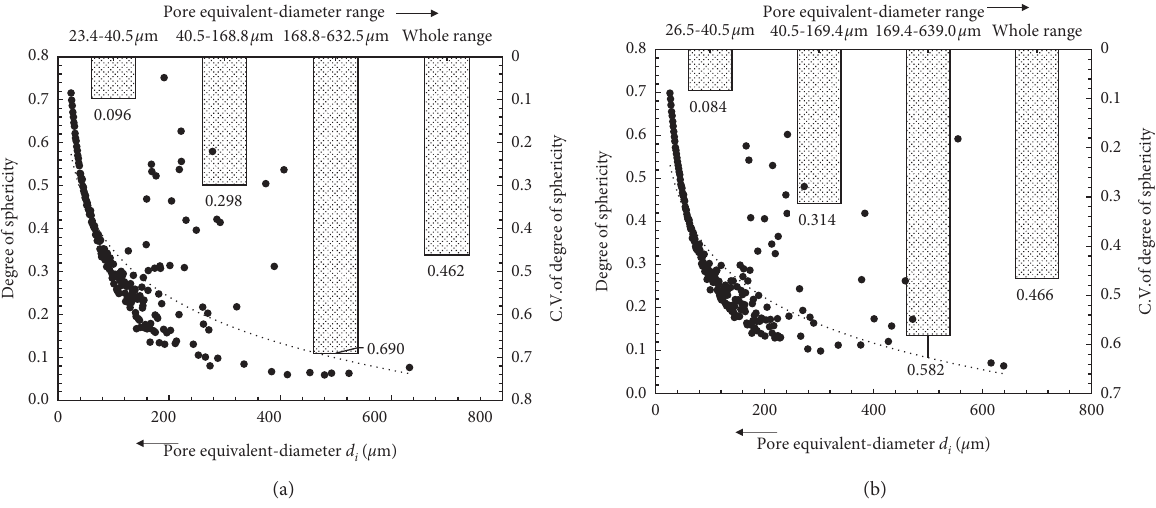
Figure 24: Sphericity distribution and its C. V. of pore-phase of NCG concretion by 3D-XRM. (a) W1N. (b) W4